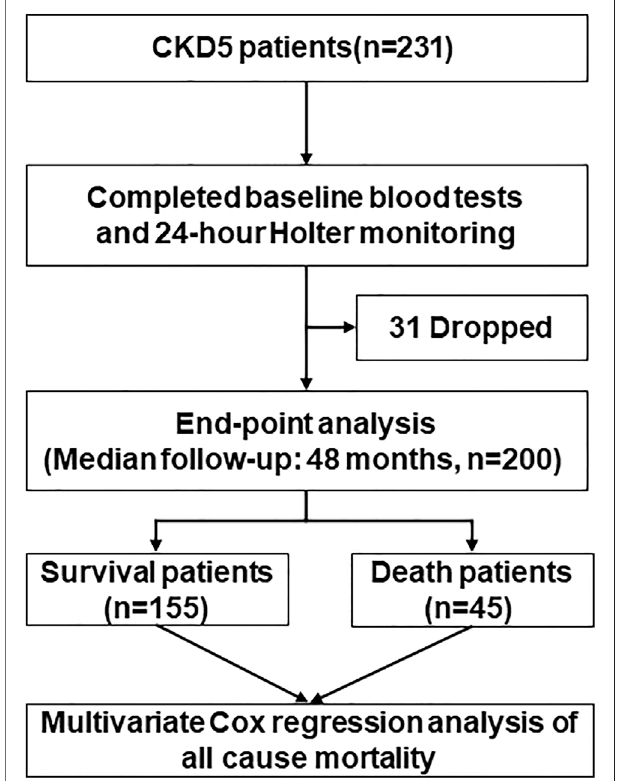
FIGURE 1 | Flow diagram of the